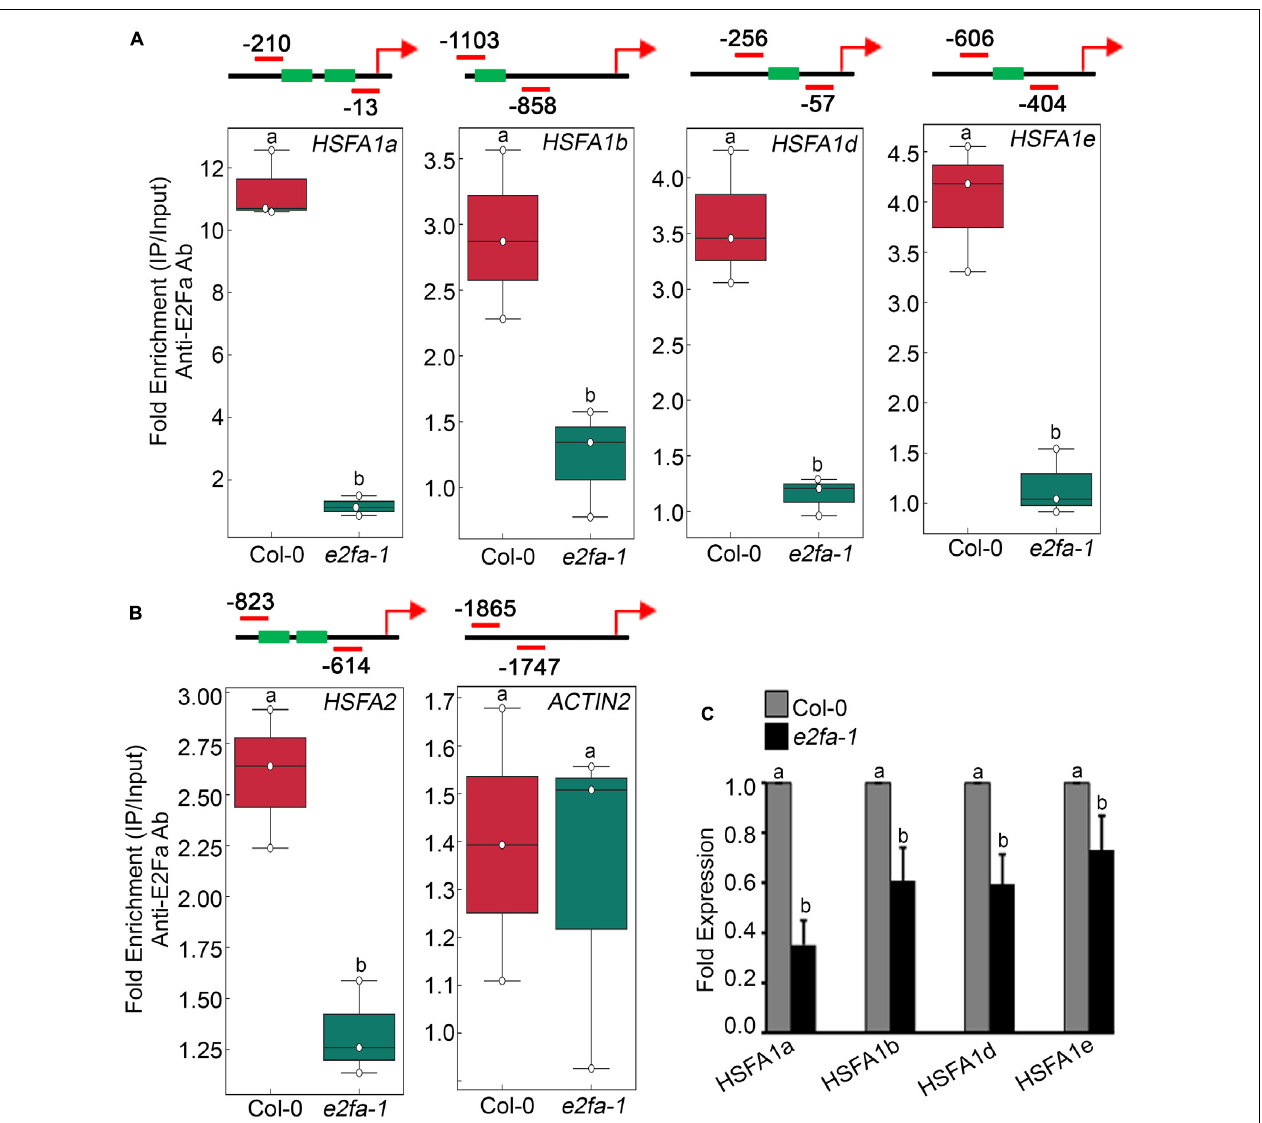
FIGURE 4 | TOR phospho-substrate E2Fa binds directly to the promoters of HSF genes. (A) ChIP assay of HSFA1a, HSFA1b, HSFA1d , and HSFA1e promoters. Amplicon position relative to ATG of HSFA1a : (–210 to –13), HSFA1b : (–1,103 to –858), HSFA1d : (–256 to –57), and HSFA1e : (–606 to –404). (B) ChIP assay of HSFA2 promoter. Amplicon position relative to ATG of HSFA2 : (–823 to –614). In panels (A,B) , In the ChIP assay, e2fa-1 mutant served as a negative background control. We also used ACT2, which does not possess any E2Fa-binding sites in its promoter region and, therefore, served as a negative target gene. Seven-day-old 0.5X MS-grown Arabidopsis Col-0 and e2fa-1 seedlings were used for the ChIP assays. Fold enrichment of promoter fragments was calculated by comparing samples treated without or with Anti-E2Fa-specific serum. CT values without and with anti-E2Fa serum were normalized by input control. The green boxes represent putative E2F-binding elements in the HSF promoters. ChIP-qPCR analysis was performed on three technical replicates ( n = 3) from a single representative experiment. The experiment was independently repeated two times (biological replicates; n = 2). Different letters denote statistical differences at p < 0.05 as assessed by one-way ANOVA and Tukey’s HSD post hoc test. (C) RT-qPCR showing expression of HSFA1 genes in Col-0 and e2fa-1 mutant. Five-day-old Arabidopsis Col-0 and e2fa-1 seedlings were used. Experiments were independently repeated two times (biological replicates; n = 2). Bar plots represent mean values, and error bars denote SD. Different letters denote statistical differences at p < 0.05 as assessed by one-way ANOVA and Tukey’s HSD post hoc